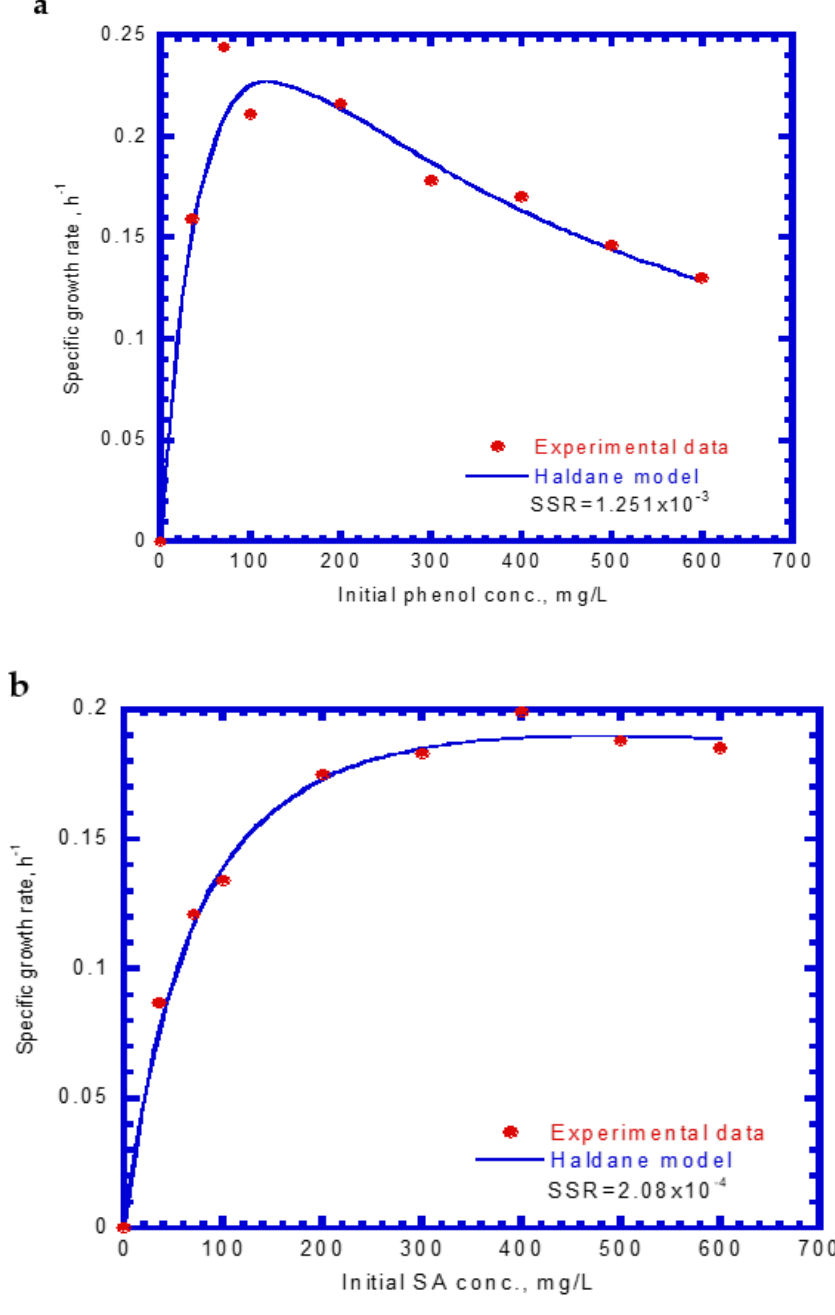
Figure 3. The variation of the specific growth rate of P. putida cells at different initial concentrations of ( a ) phenol and ( b ) sodium salicylate.